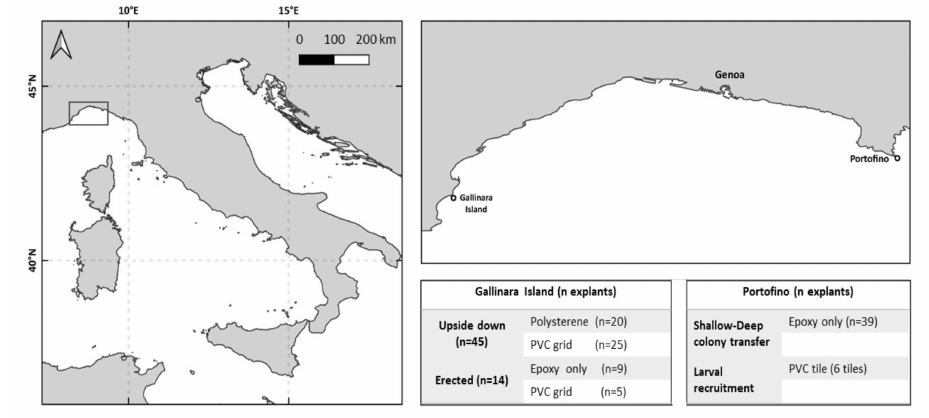
Figure 1. Location sites of the transplantations experiments with the number of fragments transplants (explants) at each location for each